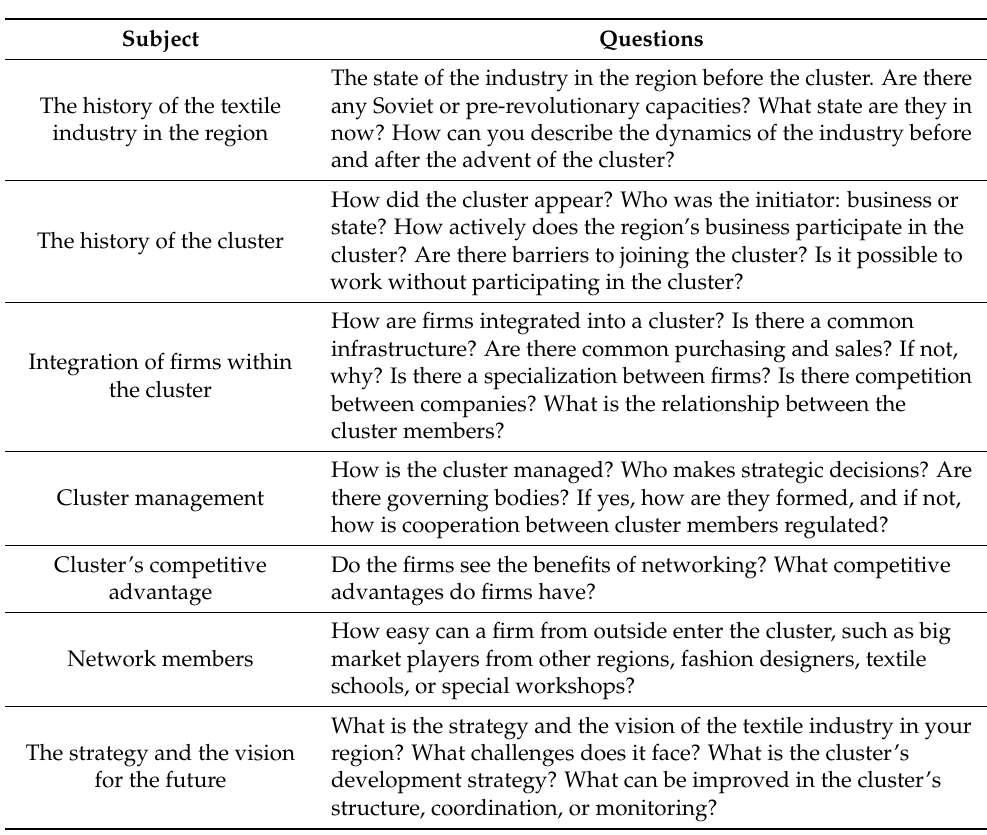
Table A4. Questionnaire for interviewing participants of the textile